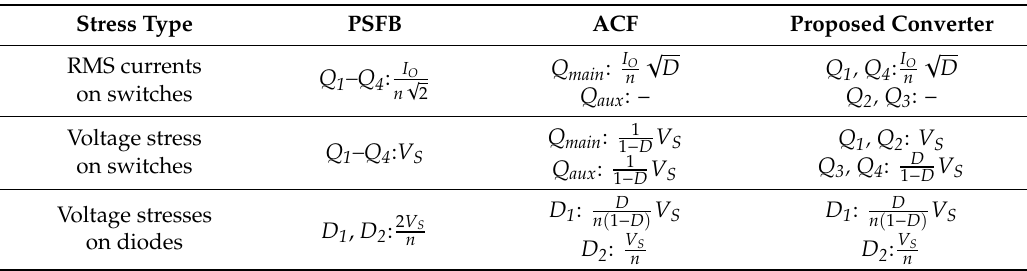
Table 1. Components stresses comparison among the conventional and proposed converters.